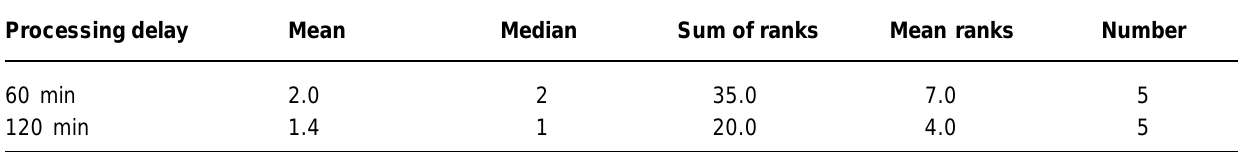
U=5.00000000;Exact probability = 0.150794; Normal approximation: